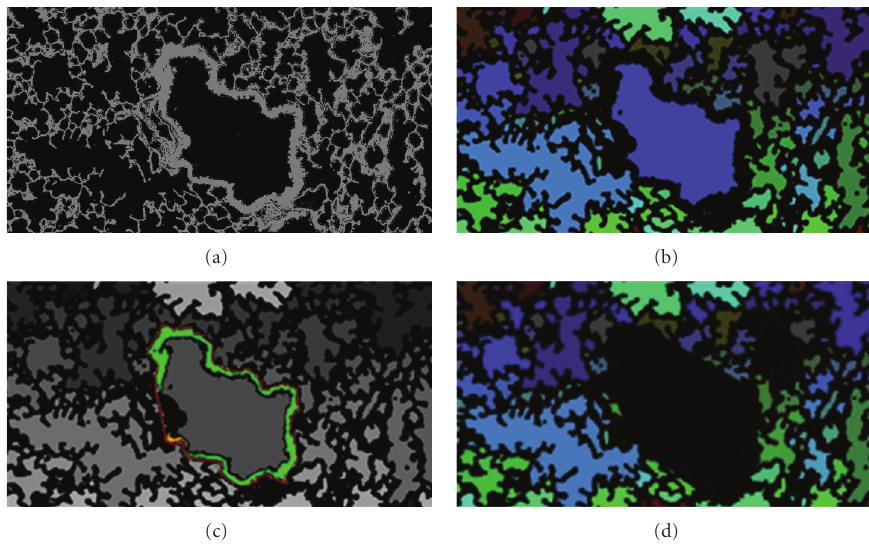
Figure 6: (a) Binarized image of H&E sample shown in Figure 4. (b) Image of the segmented alveoli calculated by connected component labeling. Notice how the large vessel in the center of the image is mistakenly included as airspace. (c) Vessel wall and its convex hull. (d) Removal of the vessel based on the intersection of the centroid of the vessel with the convex hull of the